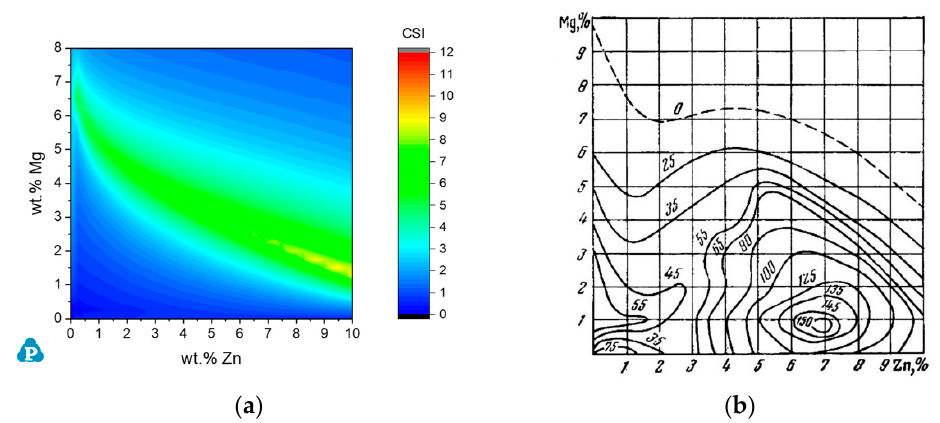
Figure 6. Al-Mg-Zn cracking susceptibility maps: ( a ) by improved Scheil model with the cooling rate of 20 °C/s and ( b ) experimentally tested data [56] (Reprinted with permission from ref. [4]. Copyright 2004 Elsevier).